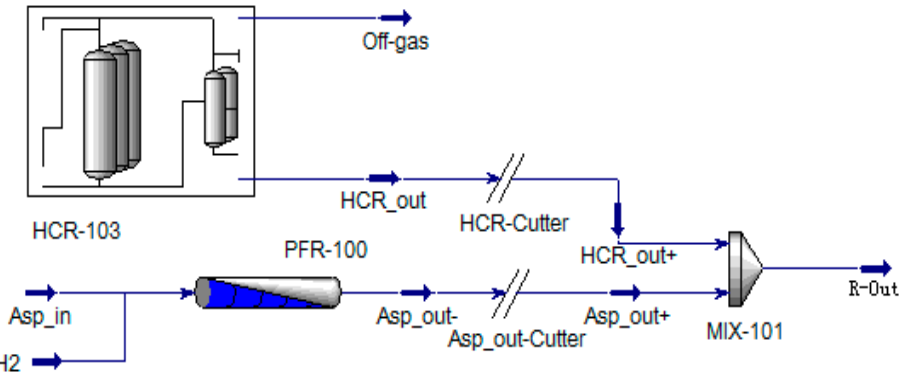
Figure 7. Two parallel structure reactor model.